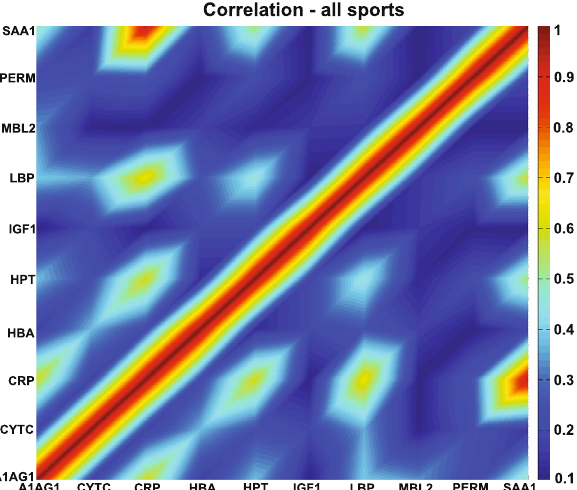
Figure 2. CRP and LBP and CRP and SAA1 are strongly correlated protein pairs. Matrix of pairwise correlations among proteins, considering all sports, athletes, and states (HOLO). The absolute value of correlations is considered. Spearman correlation was used, and no p-value filter was applied. Full data are presented in Supplementary Material 1. Alpha-1-acid glycoprotein—A1AG1; Albumin—ALBU; Cystatin C— CYTC; C-reactive protein CRP; Hemoglobin beta chain—HBA; Haptoglobin—HPT; Insulin-like growth factor 1—IGF1; Lipopolysaccharide binding protein—LBP; Mannose-binding lectin—MBL2; Myeloperoxidase— PERM and Serum amyloid